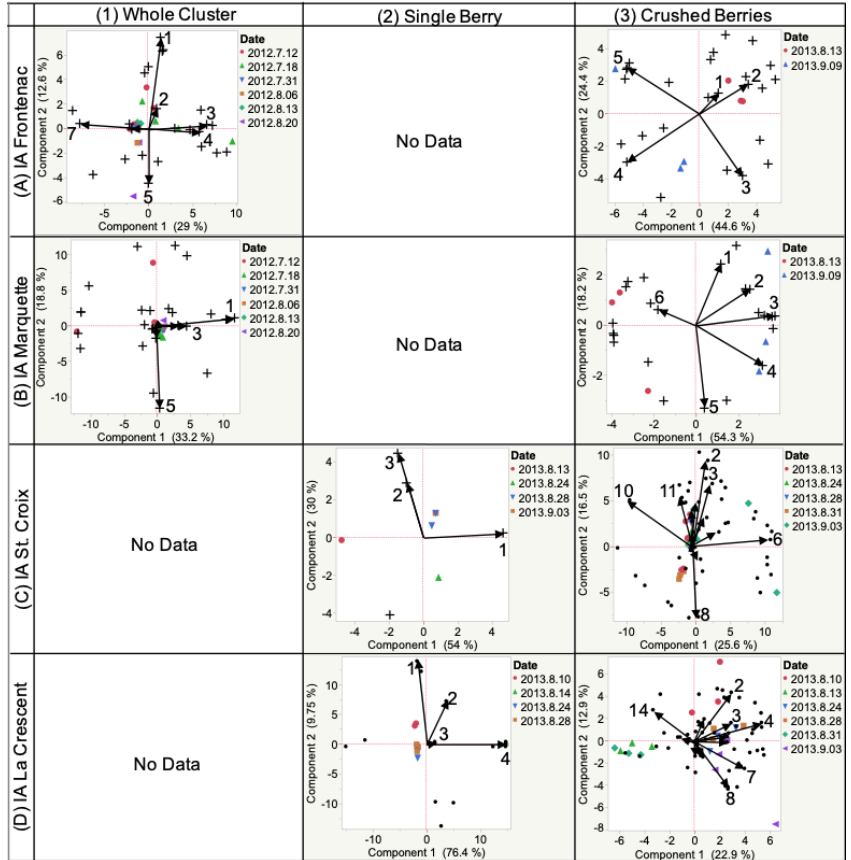
Figure A1. Results of a PCA on VOCs emitted from Iowa cold-hardy grapes by sampling methods (1) whole cluster, (2) single berry, (3) crushed berries, and cultivars ( A ) Frontenac, ( B ) Marquette, ( C ) St. Croix, ( D ) La Crescent. These plots show the relationships of grape maturity during ripening (Date) to each other and the associations among the most representative variable from cluster analysis. Key: 1A: 1 = 3-Methyl-1-butanol, 2 = 5-(Hydroxymethyl)-2-furancarboxaldehyde, 3 = Nonanal, 4 = 4-Methyl-3-penten-2-one, 5 = 1,4-Butanolide, 6 = Benzophenone, 7 = Heptanal; 1B: 1 = 1-Octanol, 5 = Acetaldehyde, 3 = Methyl ethyl ketone, 2 =